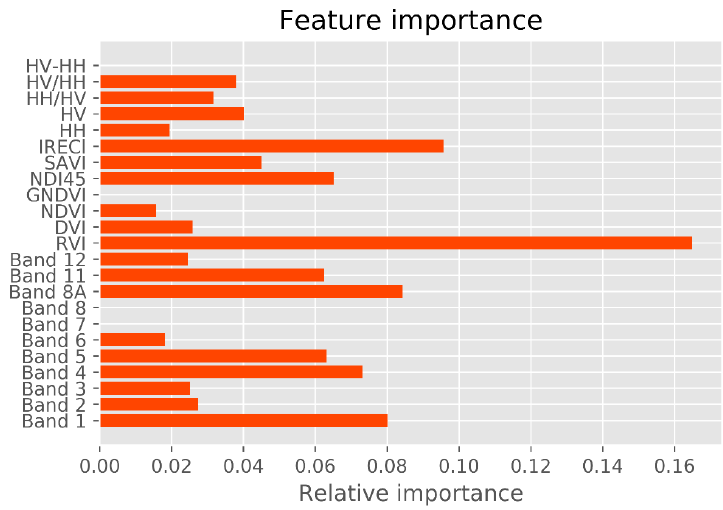
Figure 6. Variable importance comparison of S-2, VIs, and ALOS-2 PALSAR-2 data in this study.